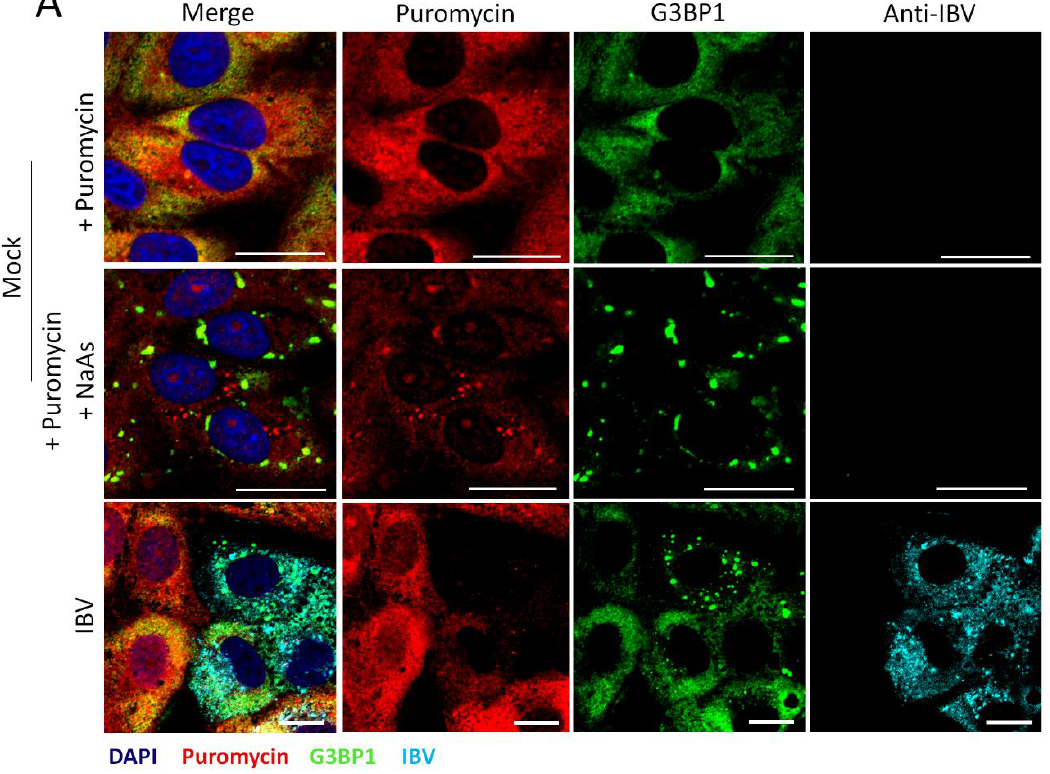
Figure 8. SG formation in IBV infected cells is correlated with increased translational shut-off. ( A ) Vero cells were mock infected or infected with IBV. At 23 hpi, positive control cells were treated with sodium arsenite (NaAs), to induce inhibition of translation. At 24 hpi, cells were treated with puromycin followed by emetine. Cells were then fixed, and nascent polypeptides labelled with puromycin were detected using an anti-puromycin antibody (red), stress granules labelled with anti- G3BP1 (green) and IBV infected cells labelled with an anti-IBV antibody (cyan). Nuclei were stained with DAPI (blue). Scale bar indicates 20 µm. ( B ) Representative scatterplot of de novo protein synthesis from ( A ), measured by fluorescence intensity of the puromycin signal analyzed in 80 cells. Data presented is representative of three independent replicates. Asterisks indicate statistical significance, as measured by one-way ANOVA, *** p = 0.0004; **** p < 0.0001. 3.8. Stress Granule Formation and Translational Shut-Off during IBV Replication Are Independent of eIF2α Phosphorylation